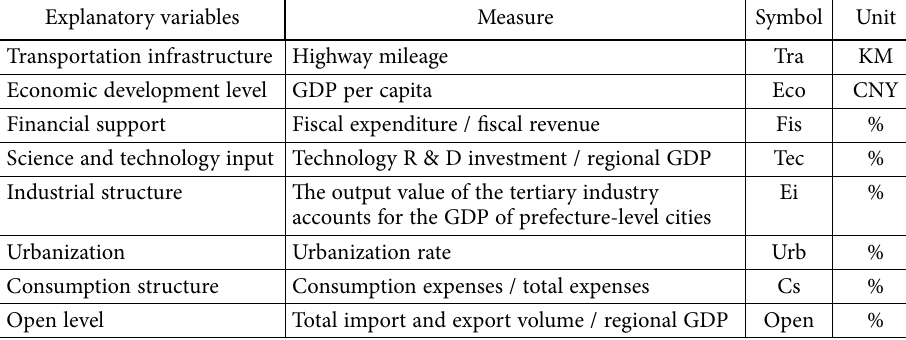
Table 2. The explanatory